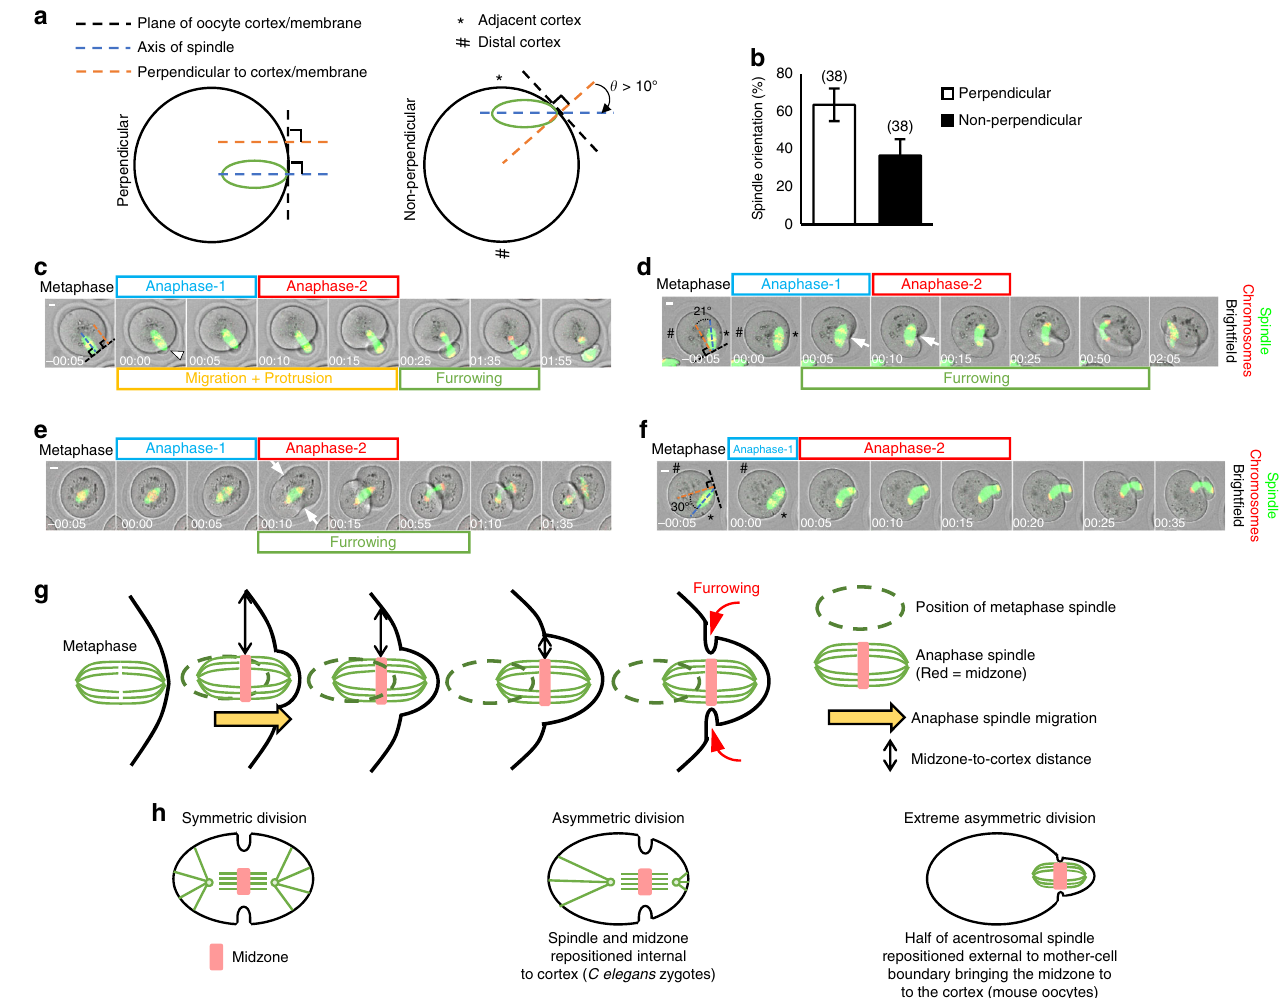
Fig. 8 Spindle migration following anaphase-onset delays furrowing. a Schematic for de fi ning orientation of cortex-proximal spindles relative to cortex. Spindles were considered non-perpendicular if θ > 10°. b Spindle orientation at anaphase-onset. Error bars are mean ± SEM. Oocyte numbers are shown in parentheses from a minimum of three independent experiments. c – f Untreated oocytes, which at the time of anaphase-onset, have spindles located either at the cortex ( c , d , f ) or at the oocyte-centre ( e ) and oriented either perpendicular ( c ) or non-perpendicular ( d , f ). Typically, asymmetry results after perpendicular spindles migrate into the membrane following anaphase-onset leading to displacement of around half of the spindle beyond the oocyte ( c ; see Supplementary Movie 30). Near-symmetrical cleavage if cortically located non-perpendicular spindles do not induce migration/protrusion ( d ; see Supplementary Movie 31). Furrowing (arrowhead) occurs at the midzone-proximal membrane (*) but not at the distal membrane (#) for cortically located spindles ( d ) and is two-sided in the case of central spindles (arrowheads, e ; see Supplementary Movie 32). Migration/protrusion enables cortically located non-perpendicular spindles to produce extreme asymmetry ( f ; see Supplementary Movie 33). g , h Model of anaphase-spindle migration/protrusion that positions half of the spindle external to the oocyte ( g ) and comparison with symmetry and asymmetry models in which the anaphase spindle remains internal to the mother cell ( h ). Times in panels are hours:minutes relative to anaphase-onset. Scale bars, 10 µ